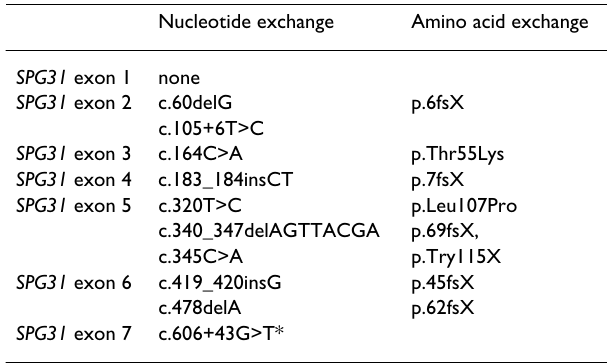
Table 3: Mutations found in